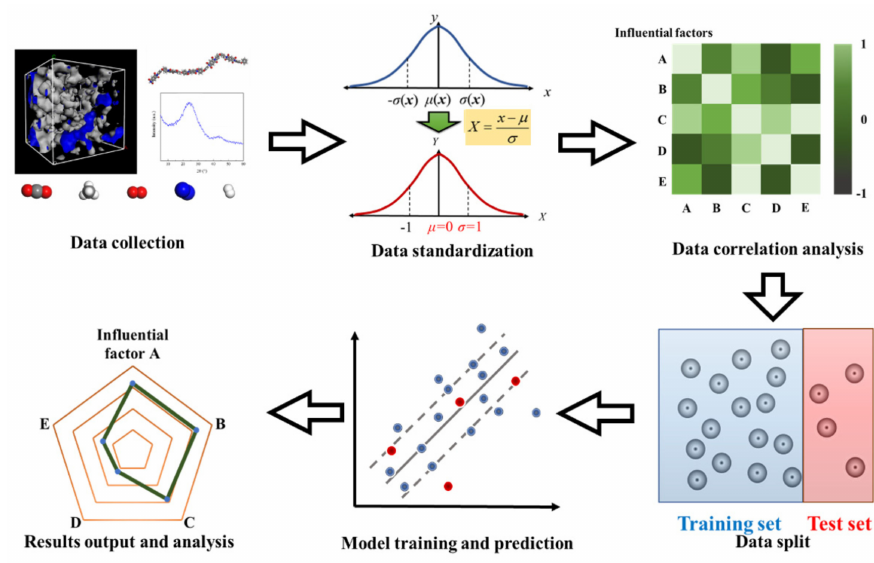
Figure 4. The processing route of influencing factor analysis based on SVR